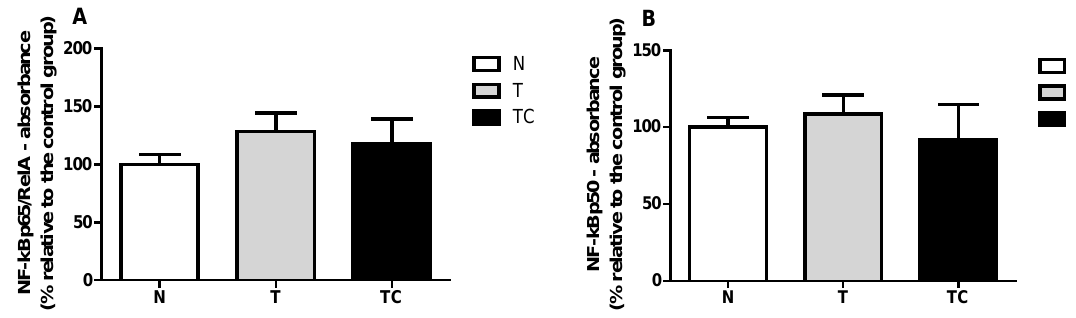
Figure A1. Western blot for nuclear and cytoplasmic protein extraction purity confirmation: β-Tubulin—51kd ( A ) and Lamin A—69 kd ( B ).